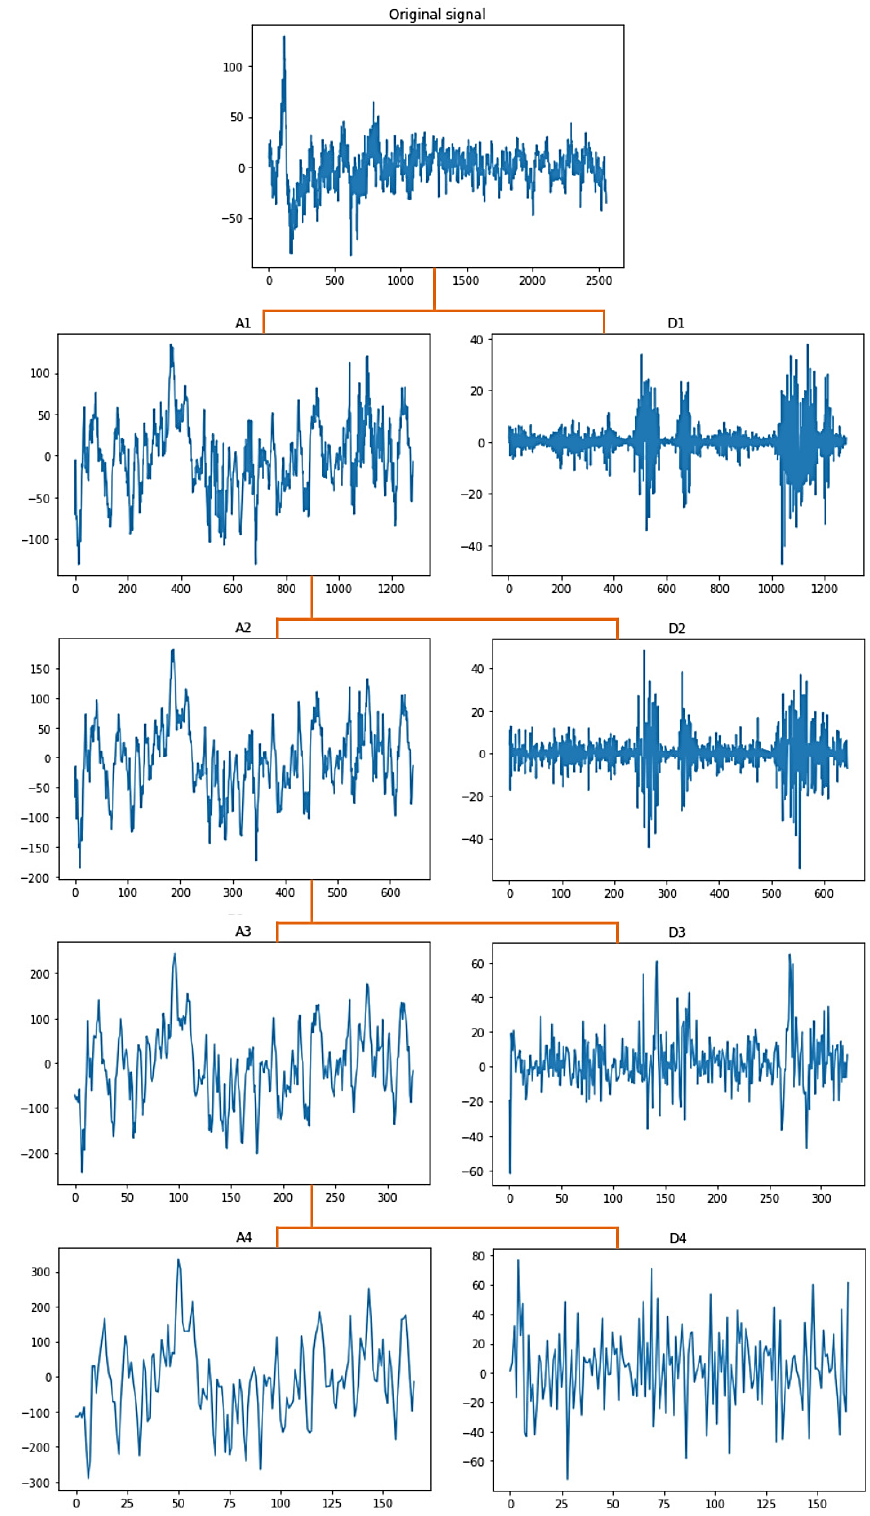
Figure 4. Approximation and detailed coefficients of the EEG signals.